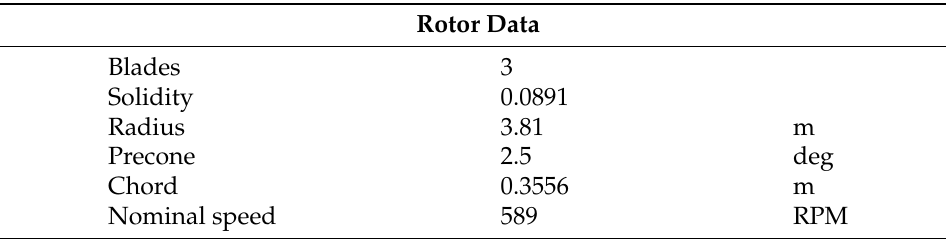
Table 4. XV-15 main rotor data [62].